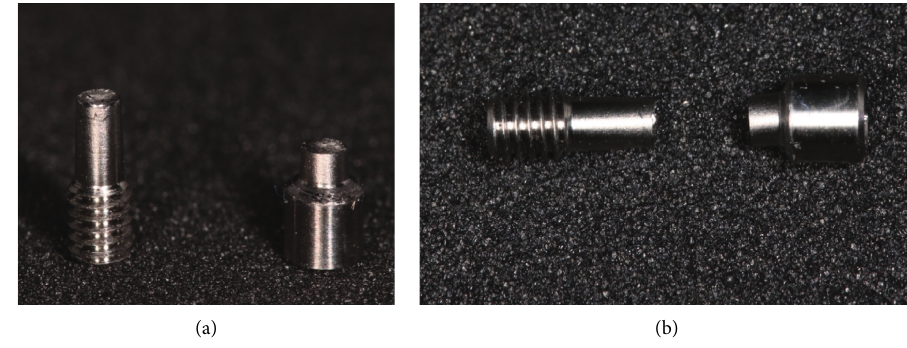
Figure 5: (a), (b) Fracture pattern of MIS ® screws.